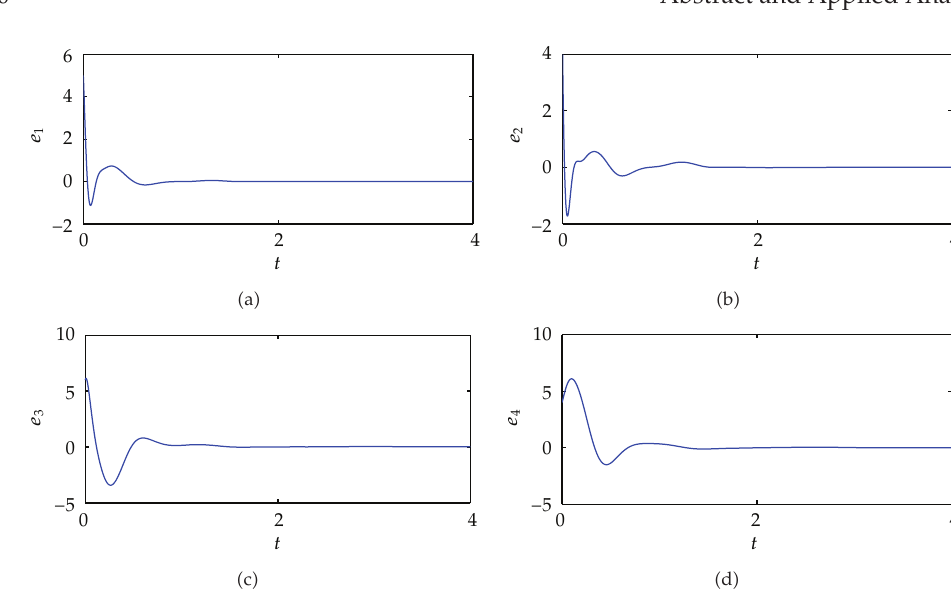
Figure 6: The modified function projective synchronization errors between the fractional-order system (cid:2) 3.6 (cid:3) and the following fractional-order system: